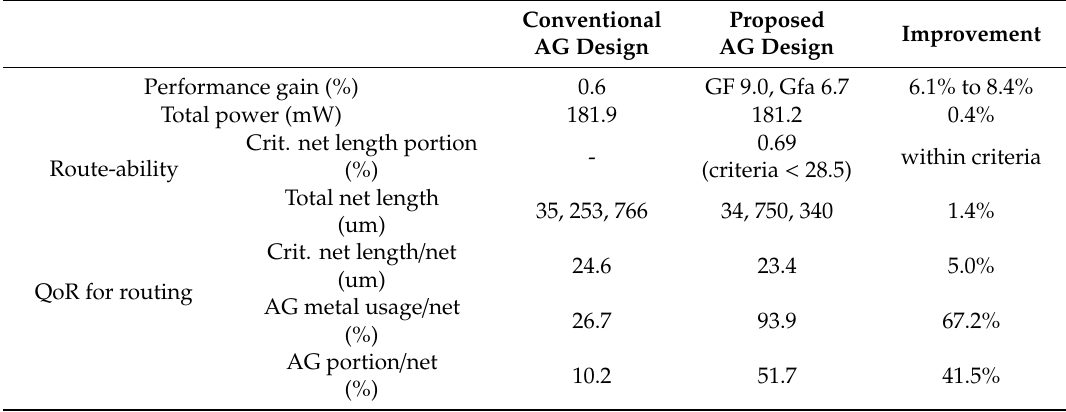
Table 2. Performance comparison on the